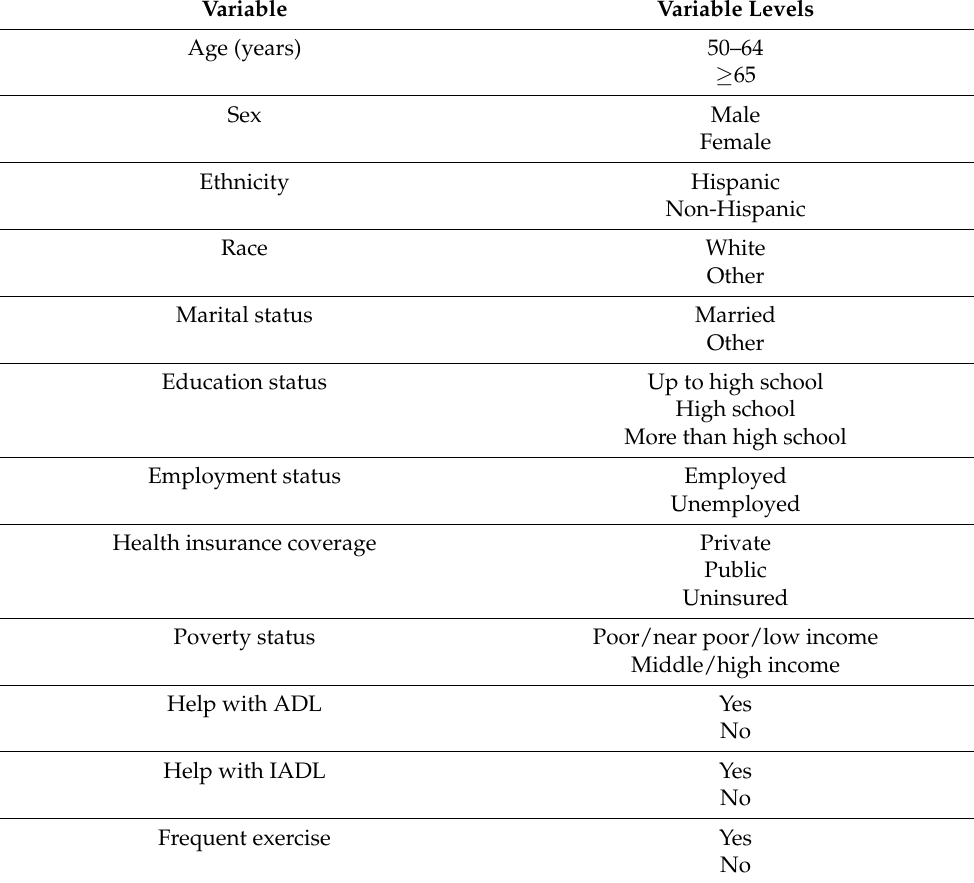
Table 1. Potential confounding variables that served as control variables in the adjusted linear regression